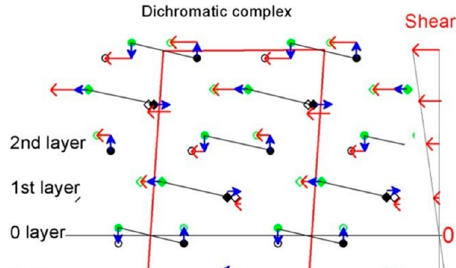
(cid:110) (cid:111) Figure 4. Dichromatic complex of the {1012} twin with the displacements of atoms, produced by Figure 4. Dichromatic complex of the 1012 twin with the displacements of atoms, produced by the passage of a disconnection, decomposed into shear (red) and shu ffl es (blue). (Reproduced from [32] the passage of a disconnection, decomposed into shear (red) and shuffles (blue). (Reproduced from with permission from Taylor & Francis Ltd., [32] with permission from Taylor & Francis Ltd., 2013).